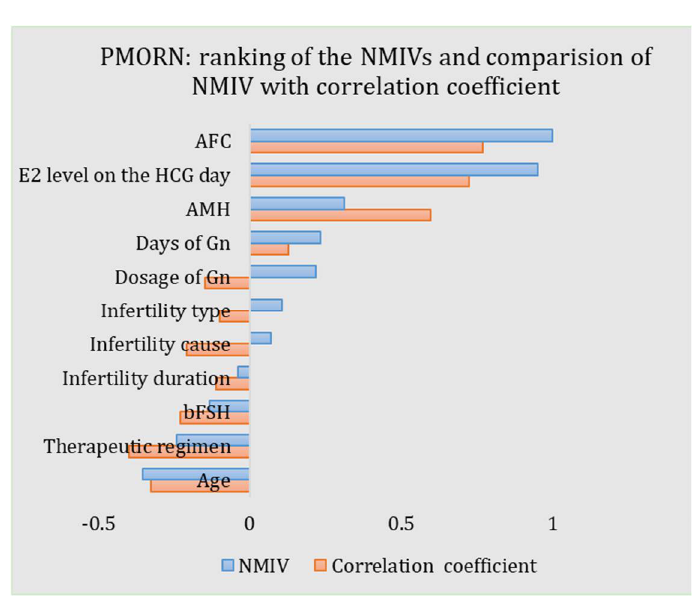
Figure 5. ANN-based PMORN: ranking of the features according to the NMIV, and the comparison of NMIV with correlation coefficient.